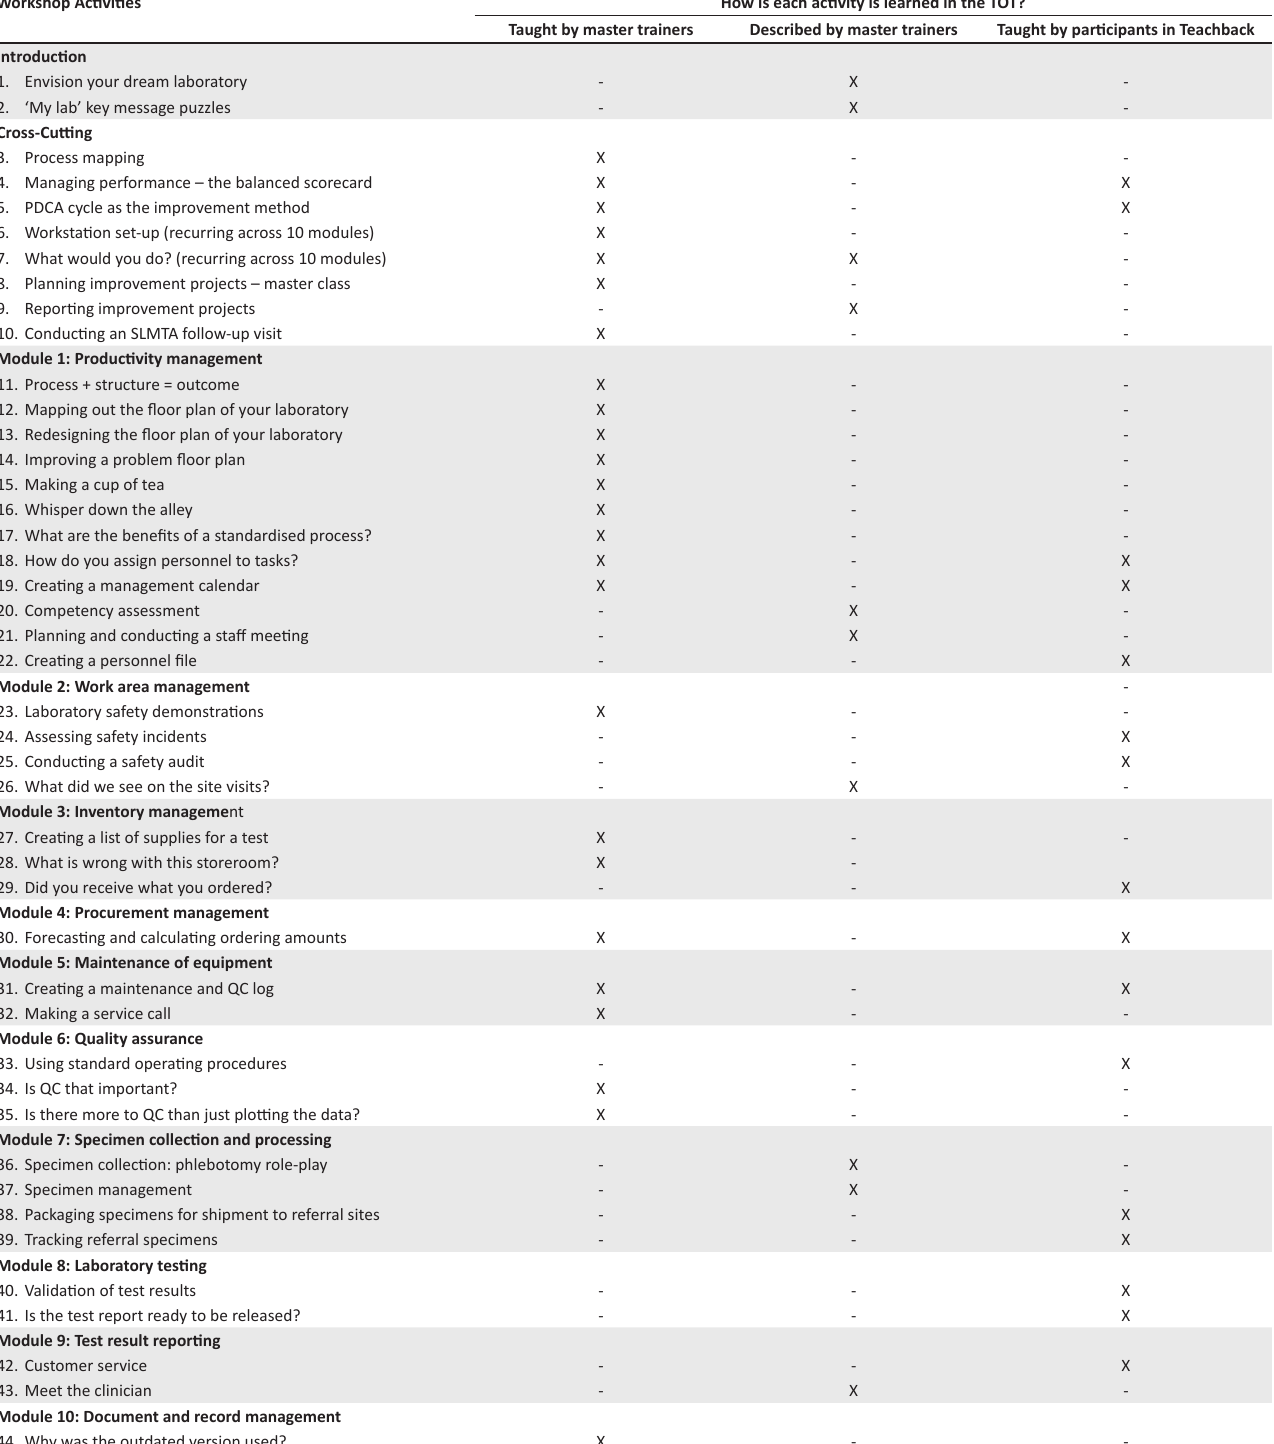
TABLE 1 : Workshop activities and how they are presented. Workshop Activities How is each activity is learned in the TOT? Taught by master trainers Described by master trainers Taught by participants in Teachback